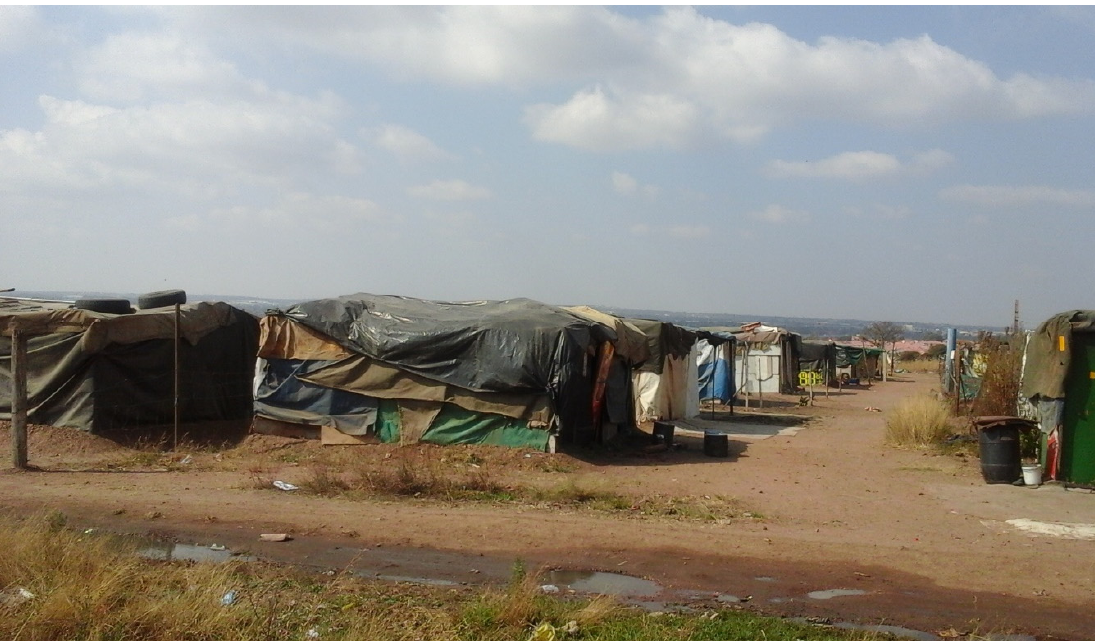
Figure A3. Bokamoso informal settlement in 2015, North West, South Africa.